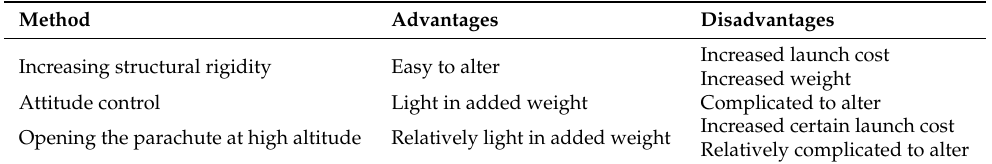
Table 4. Advantages and disadvantages of the three